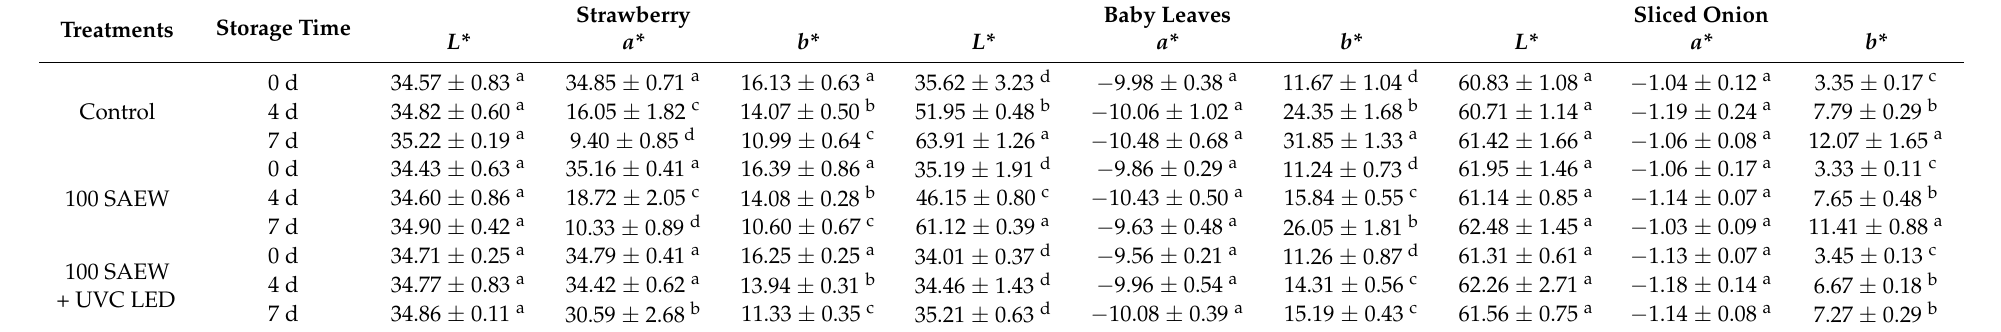
L* = lightness, a* = red-greenness, b* = blue-yellowness. Control, no extra wash with sanitizer; 100 SAEW, aerosolization with 100 ppm SAEW; 100 SAEW + UVC LED, aerosolization with 100 ppm SAEW and UVC LED irradiation (275 nm) for 3 min. a–e Different letters in the same column indicate significant differences measured by Duncan’s multiple tests at ( p <